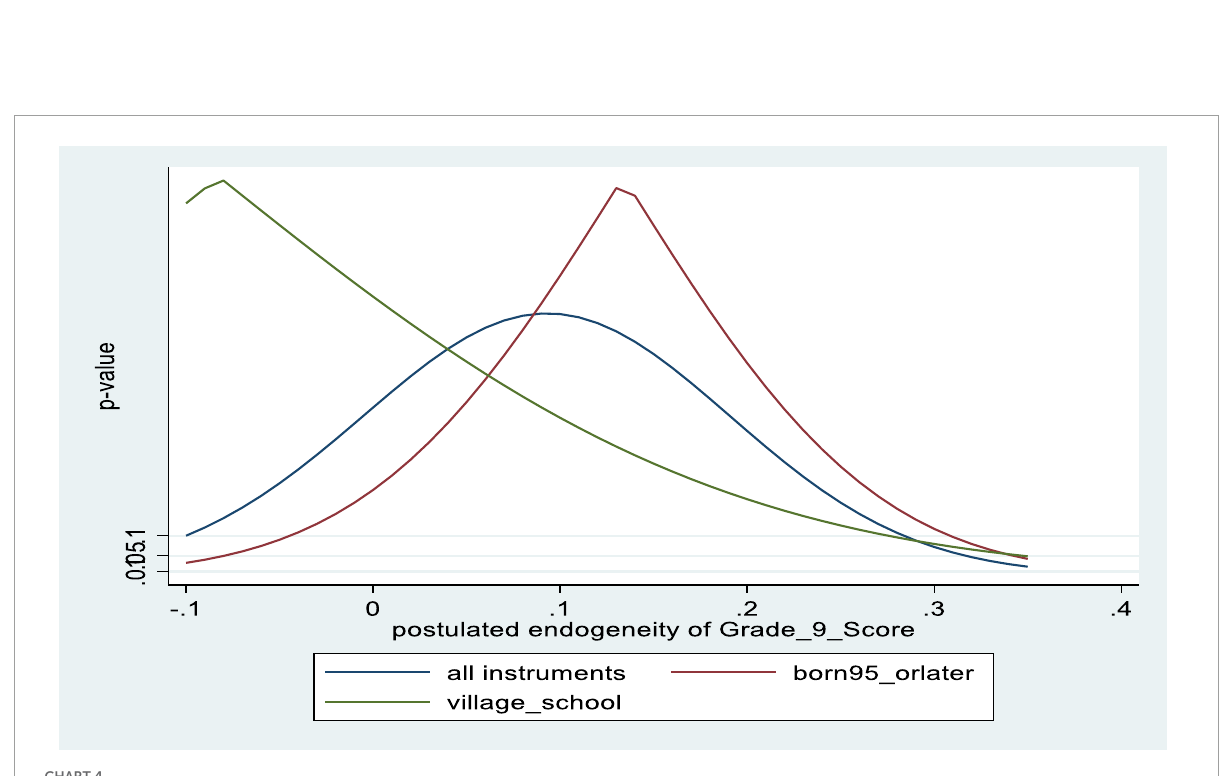
CHART4 Tests of exclusion restrictions of instruments for Grade 9 math score: